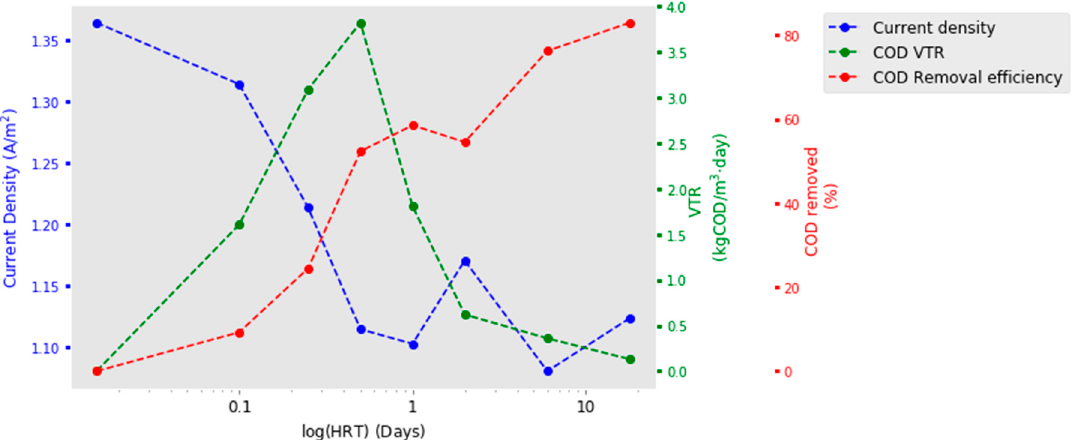
Figure 2. Current density, chemical oxygen demand (COD) removal efficiency and COD volumetric treatment rates (VTRs) with comparison to Log treatment rates (VTRs) with comparison to Log (HRT).